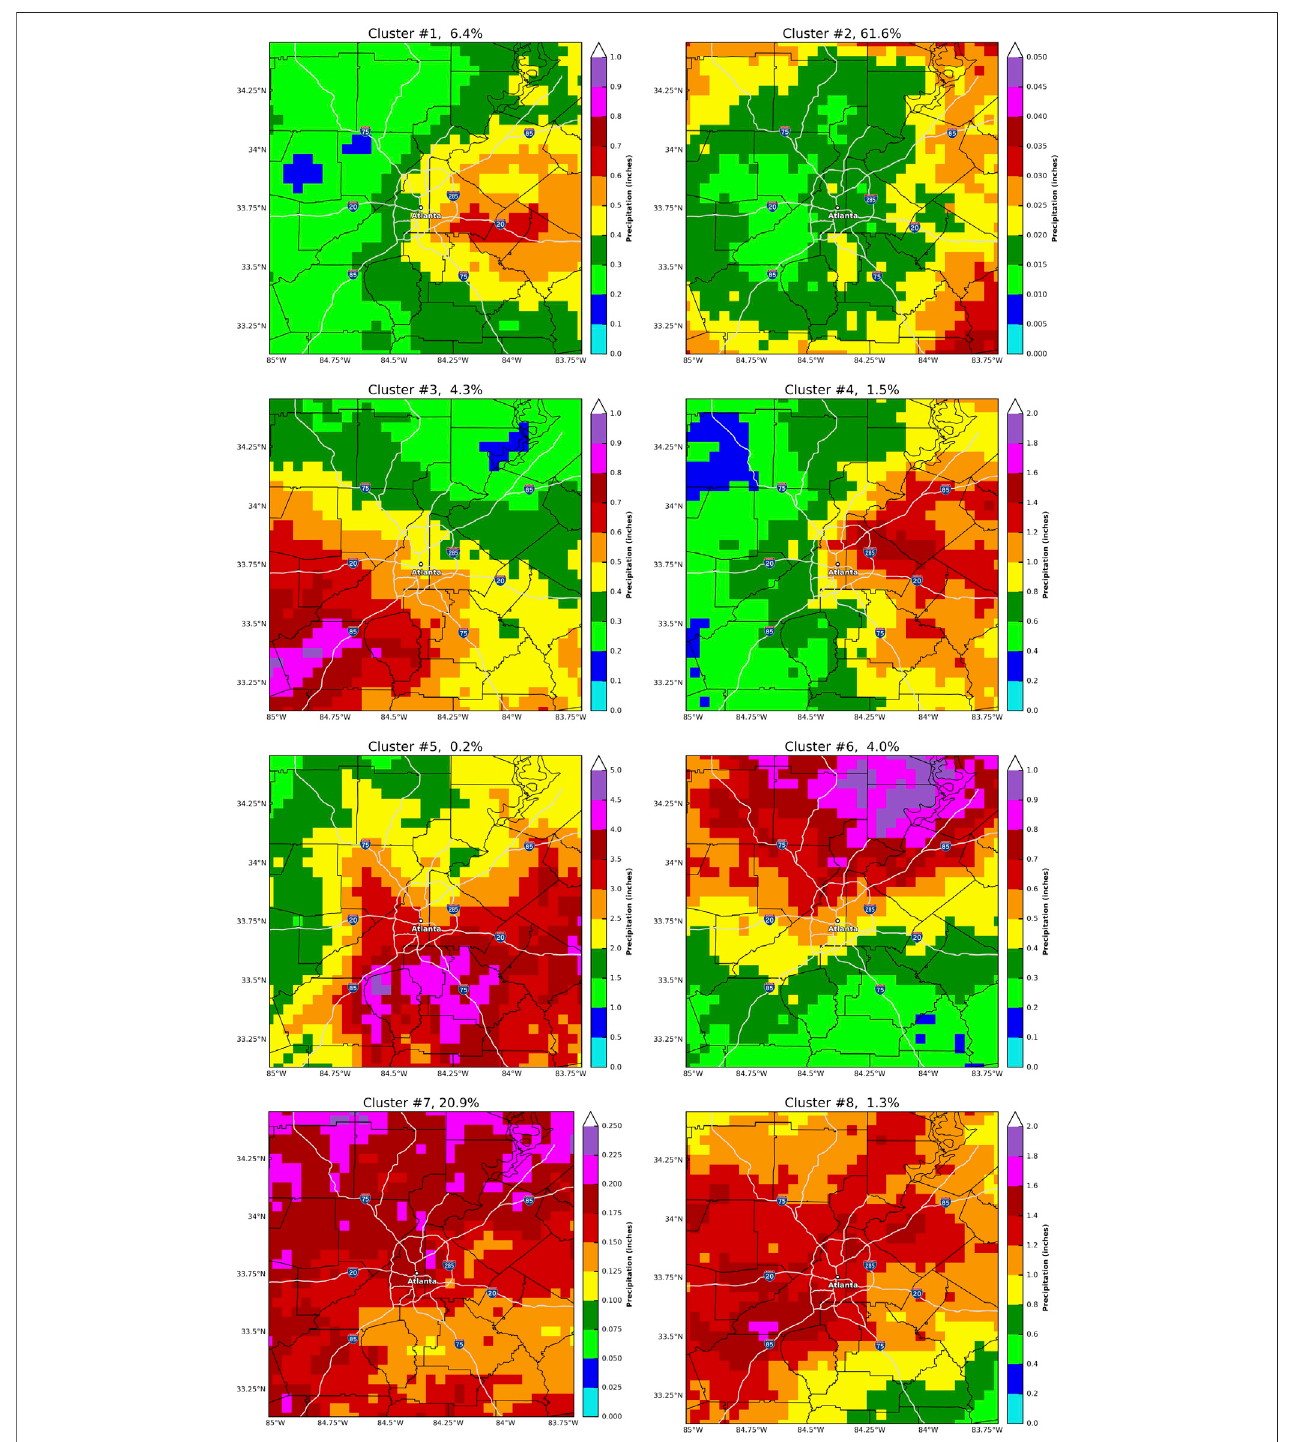
FIGURE 12 | K -means cluster maps (1 – 8), with the percentage of days associated with each cluster located at the top of each map.